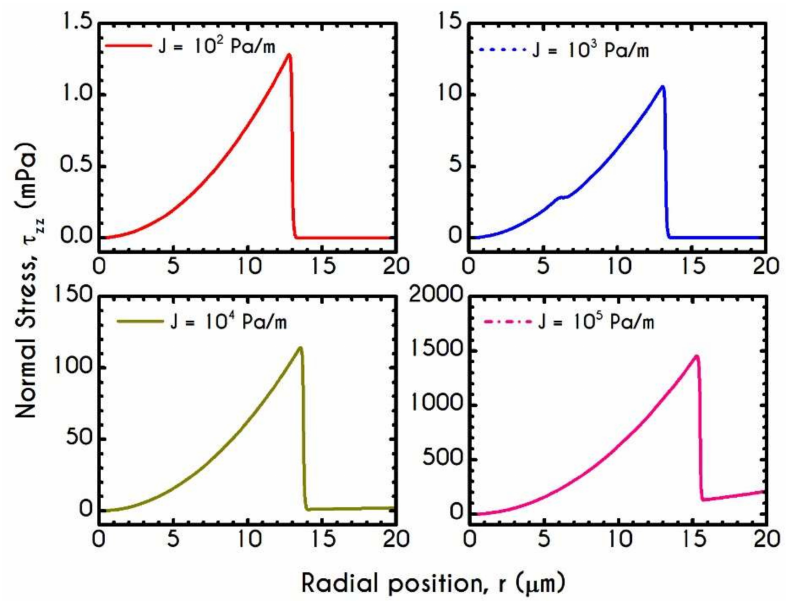
Materials 2021 , 14 , x FOR PEER REVIEW 22 of 38 Figure 17. Normal viscoelastic stress τ ve,zz along the radial position for pressure gradient J equal to 10 2 Pa/m, 10 3 Pa/m, 10 4 Pa/m, and 10 5 Pa/m, for R = 20 µ m and H c = 0.45.